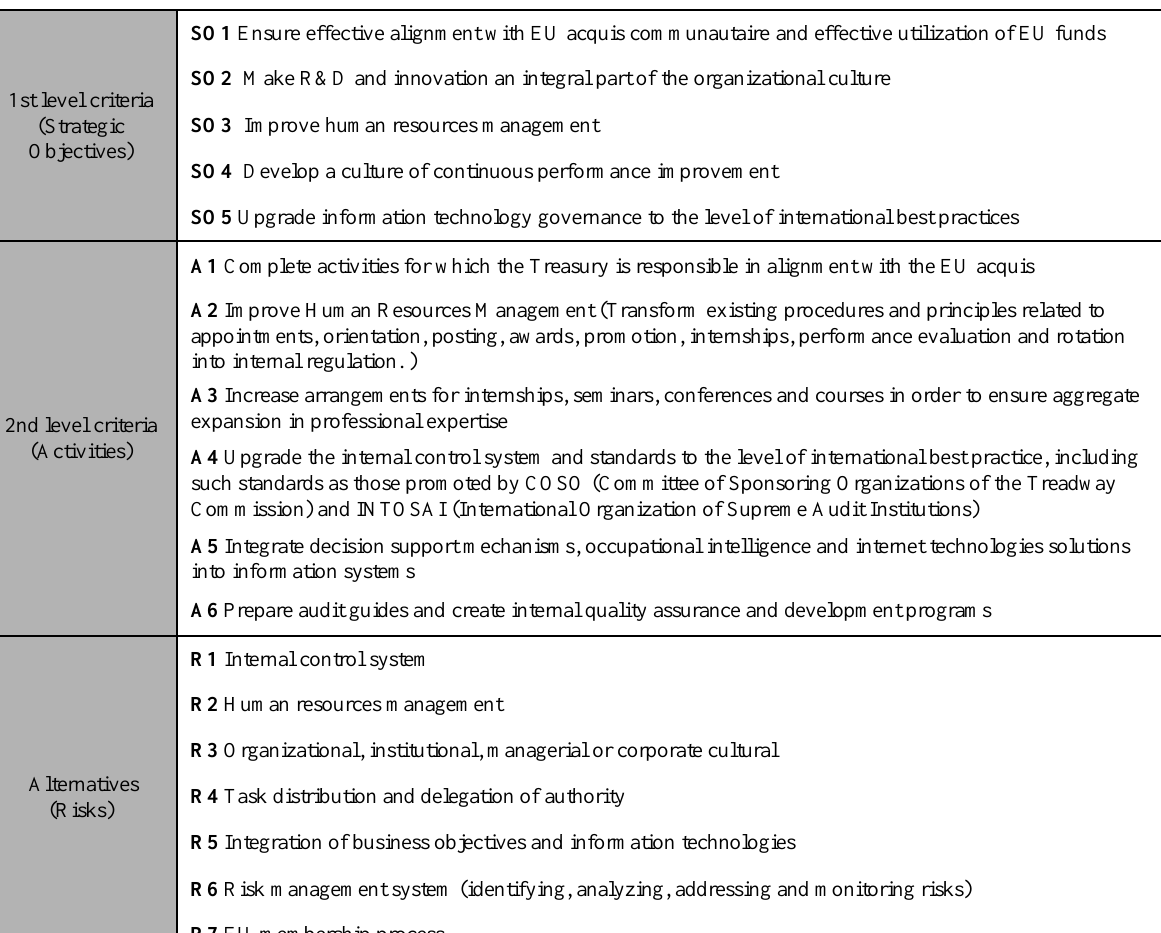
Table 2. Criteria and alternatives used in the